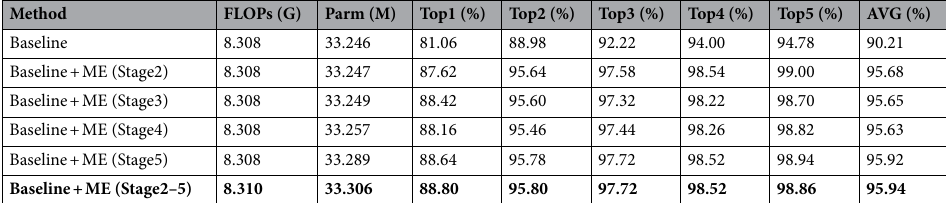
Table 5. ME module ablation test results. Significant values are in bold.